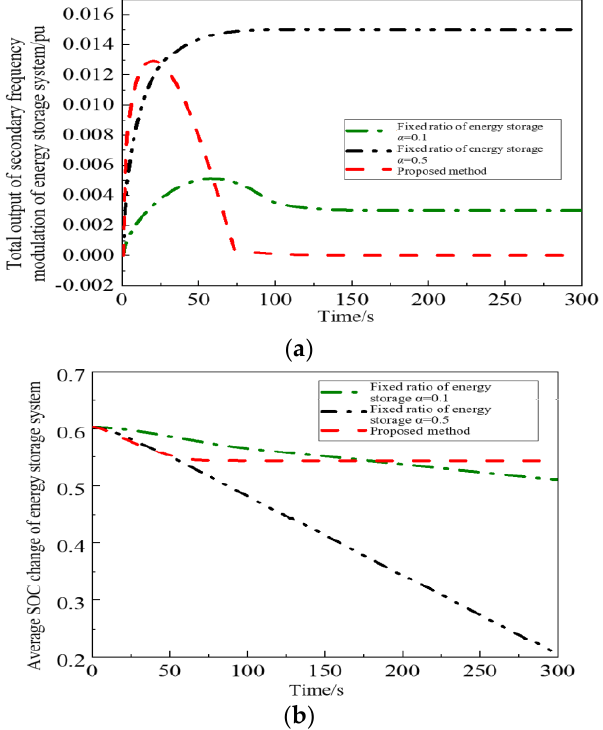
Figure 4. Change of total output and average SOC of energy storage unit under step disturbance. ( a ) Variation in total output of energy storage system. ( b ) Average SOC change of energy storage system.